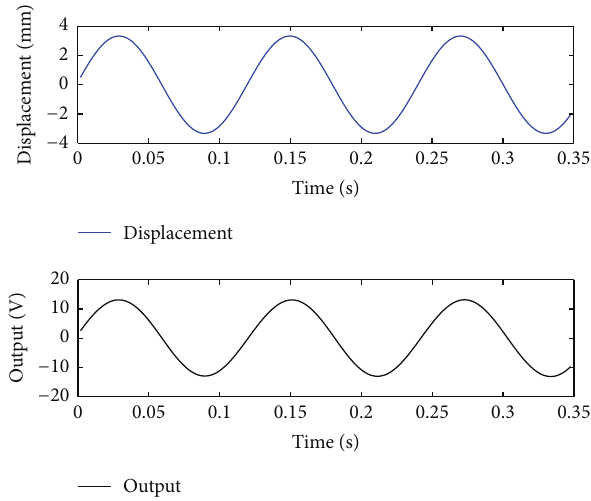
Figure 6: MFC real-time waveform of displacement and output.